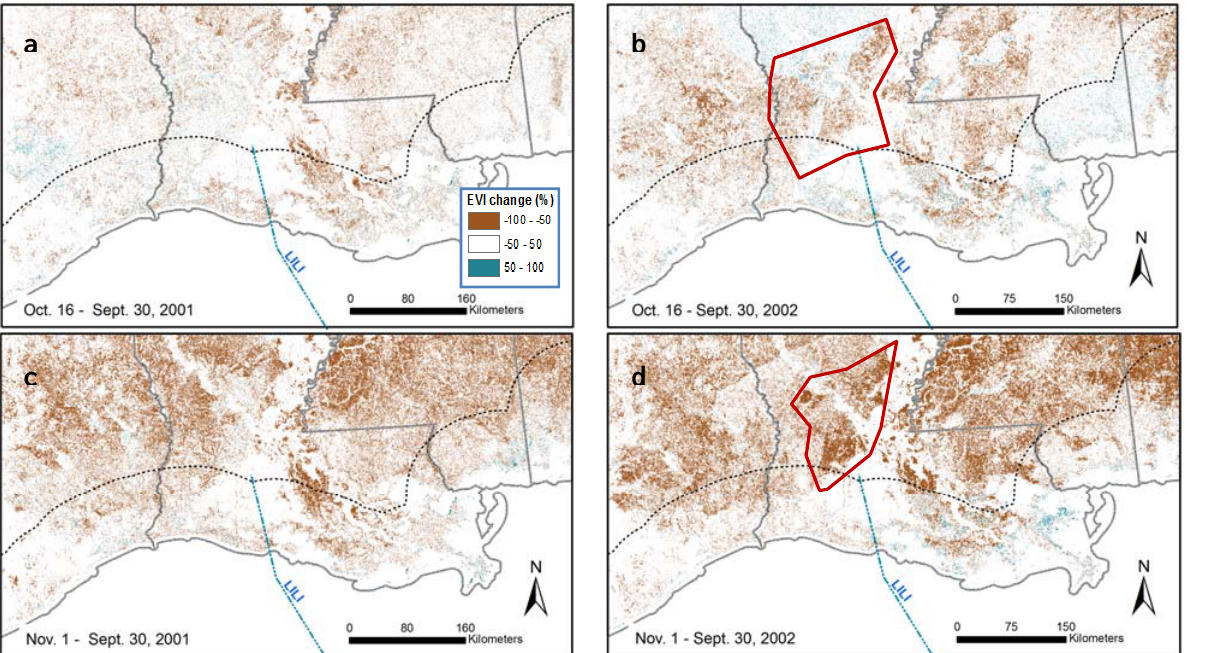
Figure 5. Greater than 45% decrease of the MODIS EVI values between two dates as shown on the maps. The images on the left column, as references, displayed the changes without hurricane disturbance. The maps on the right column represented the changes after Hurricane Lili